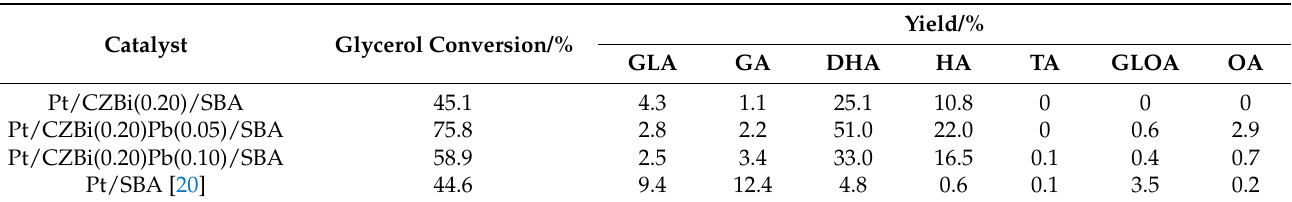
Table 1. Glycerol conversion and product yields over the Pt/CZBi(0.20)Pb( x )/SBA catalysts after the reaction for 4 h at 30 ◦